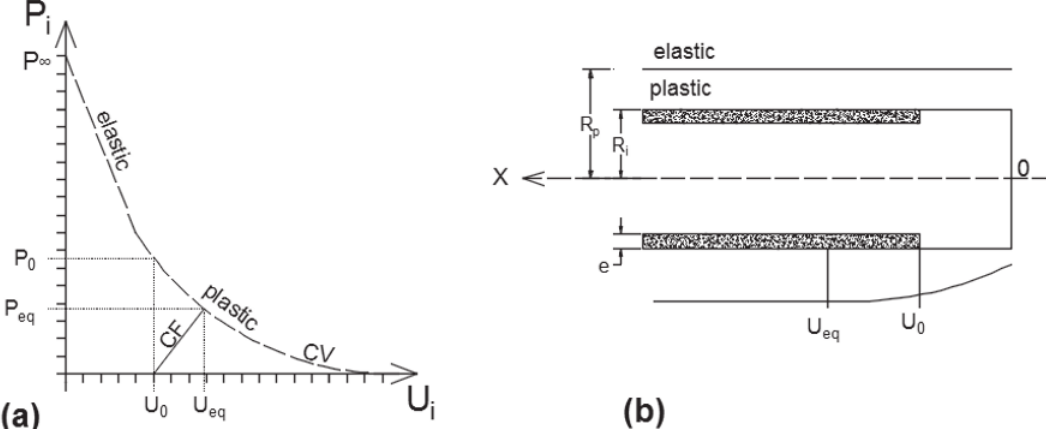
Tunnel equilibrium in a diagram Pi x Ui (a) and equilibrium of a tunnel (b) (BERNAUD and ROUSSET, 1996,